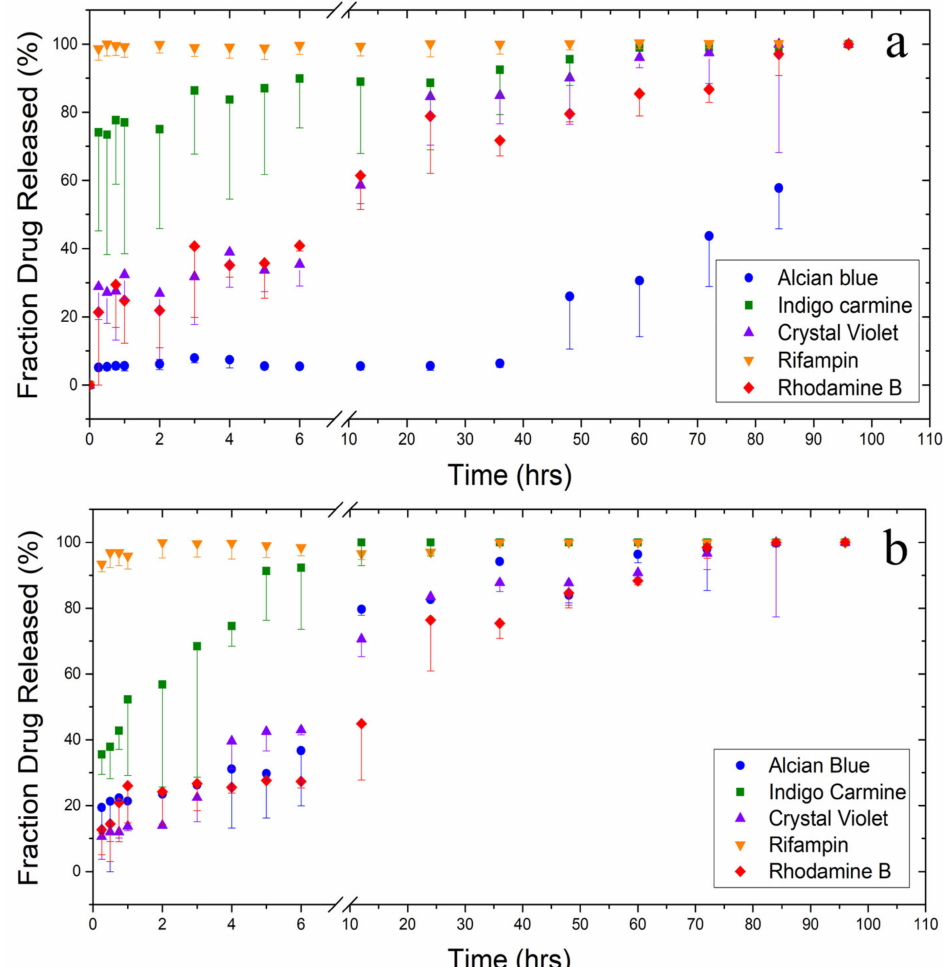
Figure 9. Release profiles from silk-model drug fibers and films. Normalized release profiles of various model drugs from silk ( a ) air-spun fibers and ( b ) thinfilms.